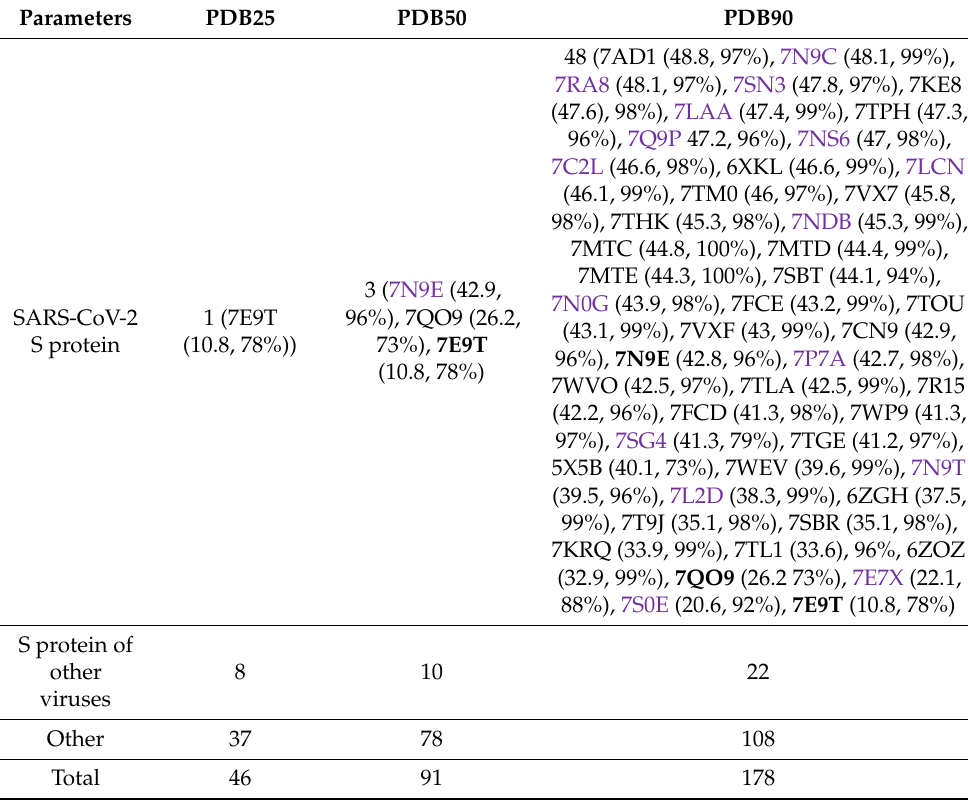
Table 2. Similar SARS-CoV-2 S protein structures. Structures highlighted in purple are S protein structures in complex with antibodies. Bold PBD IDs (PIDs) represent those S protein structures that are present in multiple search